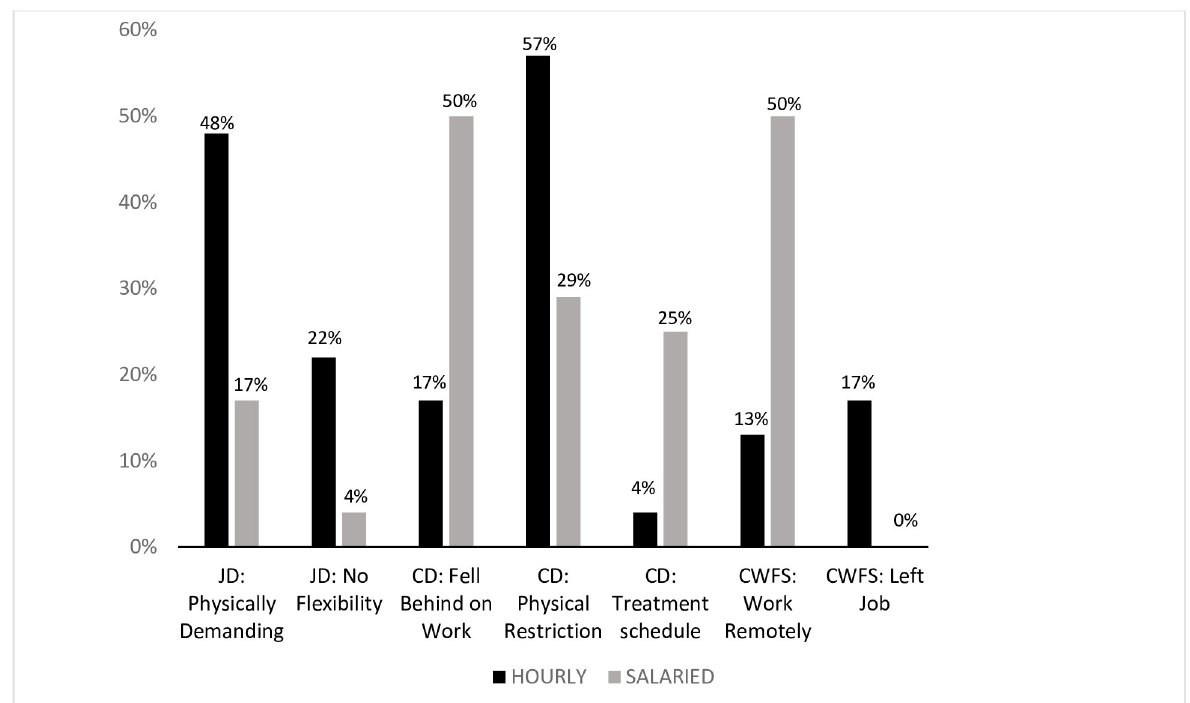
Fig 2. Comparison of hourly and salaried wage breast cancer survivors on themes related to cancer-work management (N = 48). Notes: CD: Cancer care demands; JD: Job demands; CWFS: Cancer-Work Fit Strategy.